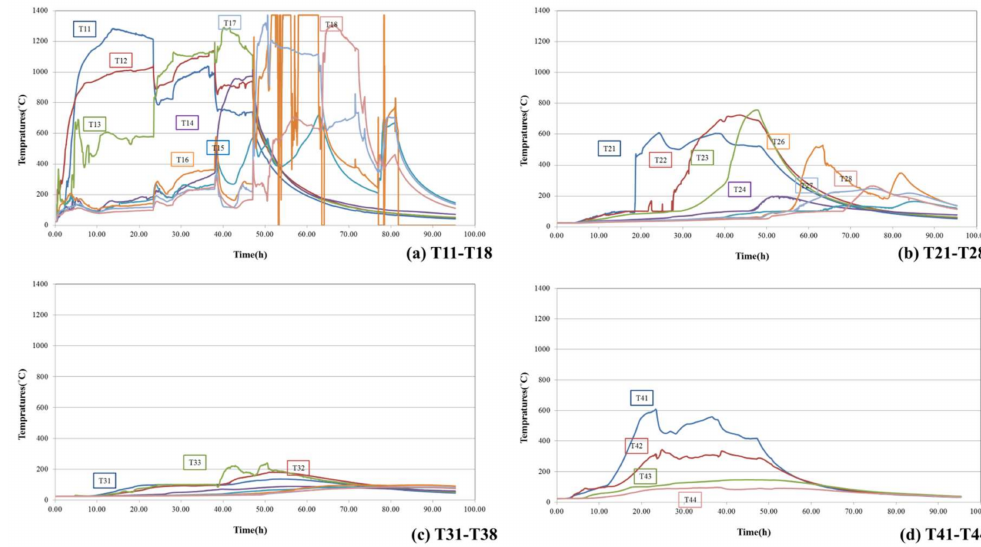
Figure 7. Temperature profiles during gasification experiment. ( a ) T11-T18; ( b ) T21-T28; ( c ) T31-T38; ( d )